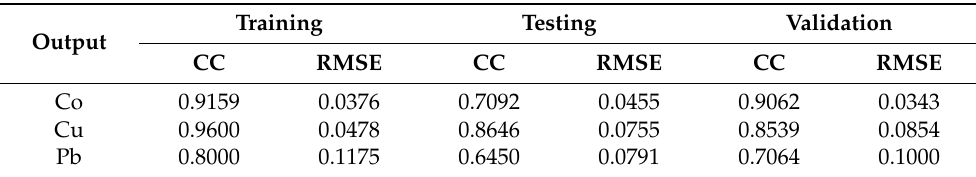
Table 5. Correlation coefficients and RMSE values of Co, Cu and Pb using boosted regression tree method for all stages.